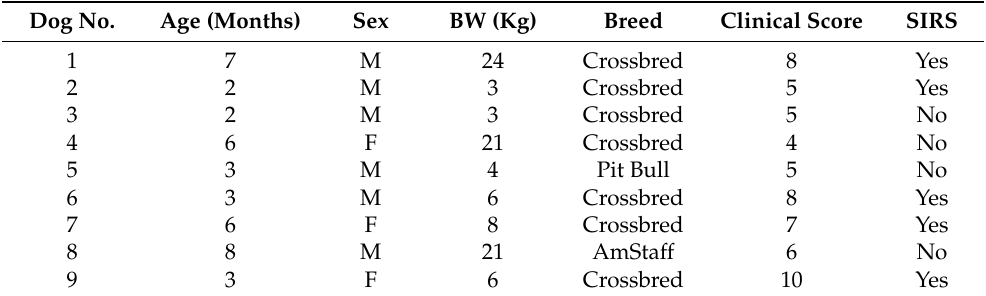
Table 2. Age, sex, body weight, breed, clinical score, and presence of systemic inflammatory response syndrome in dogs with canine parvovirus enteritis. Dog No. Age (Months) Sex